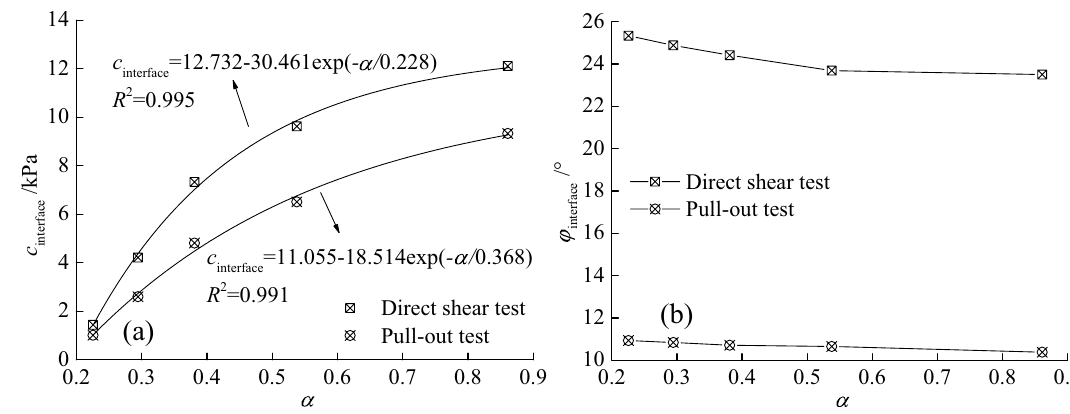
Figure 4. Relationship between geogrid mesh size and interface strength index during direct shear test: ( a ) pseudo-cohesion and ( b ) pseudo-friction